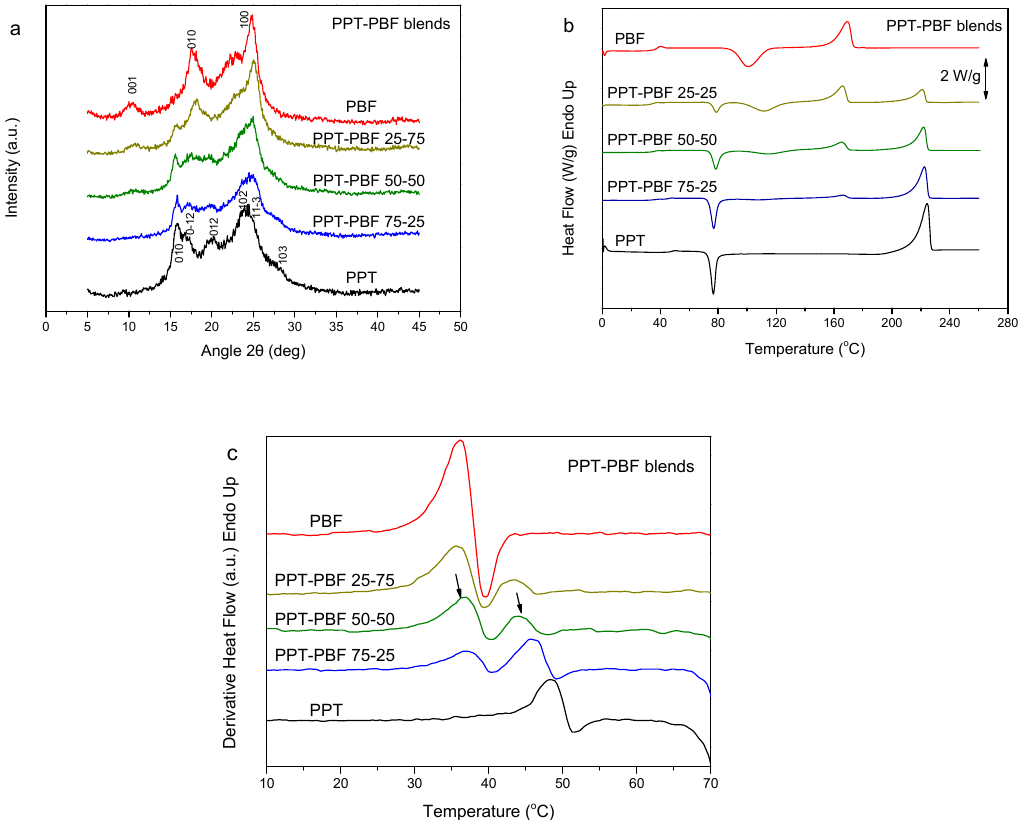
Figure 4. ( a ) WAXD patterns, ( b ) DSC traces of the melt-quenched samples upon heating, and ( c ) derivative heat flow thermograms of the poly(propylene terephthalate) (PPT)–PBF blends.